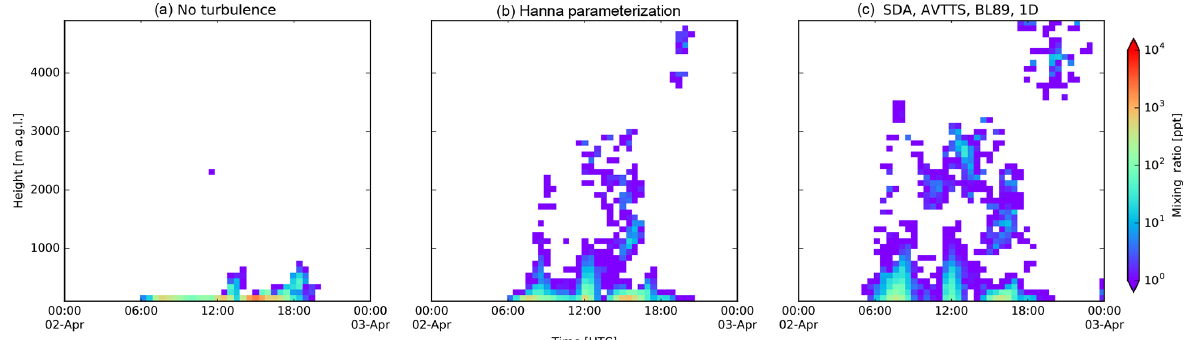
Figure 6. Marine boundary layer tracer profile evolution at the Maïdo observatory. Panel (a) : a simulation without turbulent motions taken into account. Panel (b) shows the traditional FLEXPART turbulent mode. Panel (c) shows the results with the new turbulent